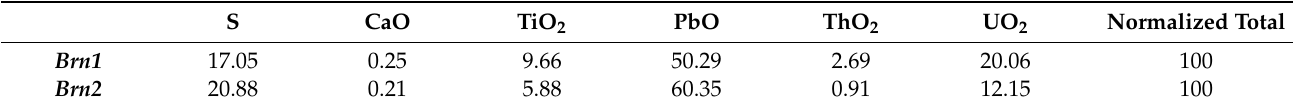
Table 2. The chemical composition of inclusions in Brn1 and Brn2